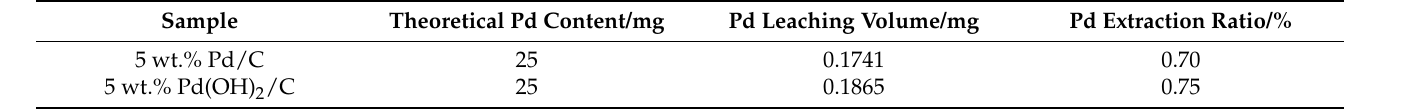
Table 3. The AAS results of the reaction filtrate.